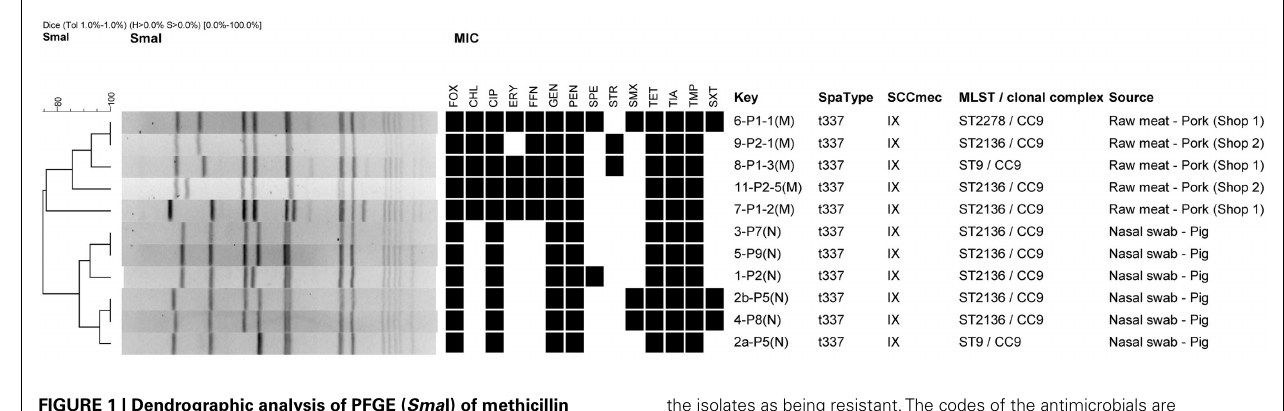
FIGURE 1 | Dendrographic analysis of PFGE ( Sma I) of methicillin resistant Staphylococcus aureus isolates originating from pork and pigs inThailand. Black squares in the dendrogramme represent